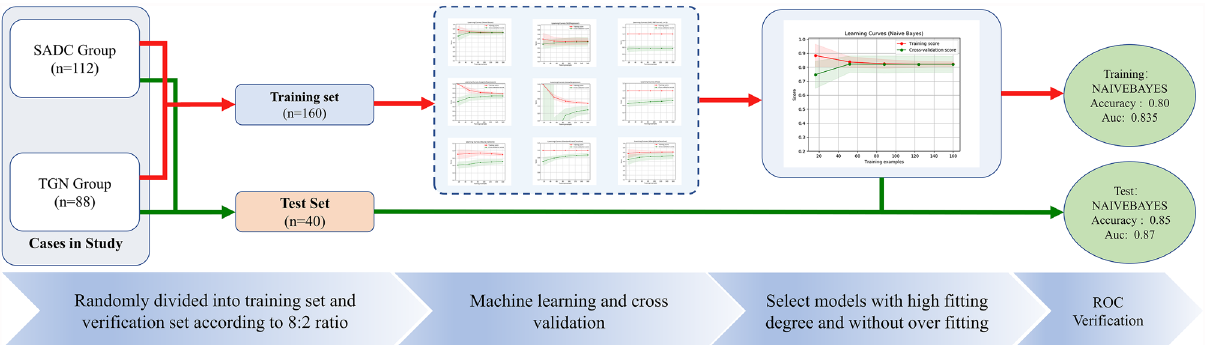
Figure 3. Machine learning flow chart. The samples after LASSO regression were randomly divided into a training group and test group at a ratio of 8:2. In the process of machine learning, 12 types of classifiers are used for training, and five times of cross-validation are performed during the learning process. Finally, the learning curve is drawn and the training score and verification score of each classifier is obtained; according to the learning curve of each classifier to score, select a classifier with a high degree of fit and no overfitting, and build and test a machine learning classification model.